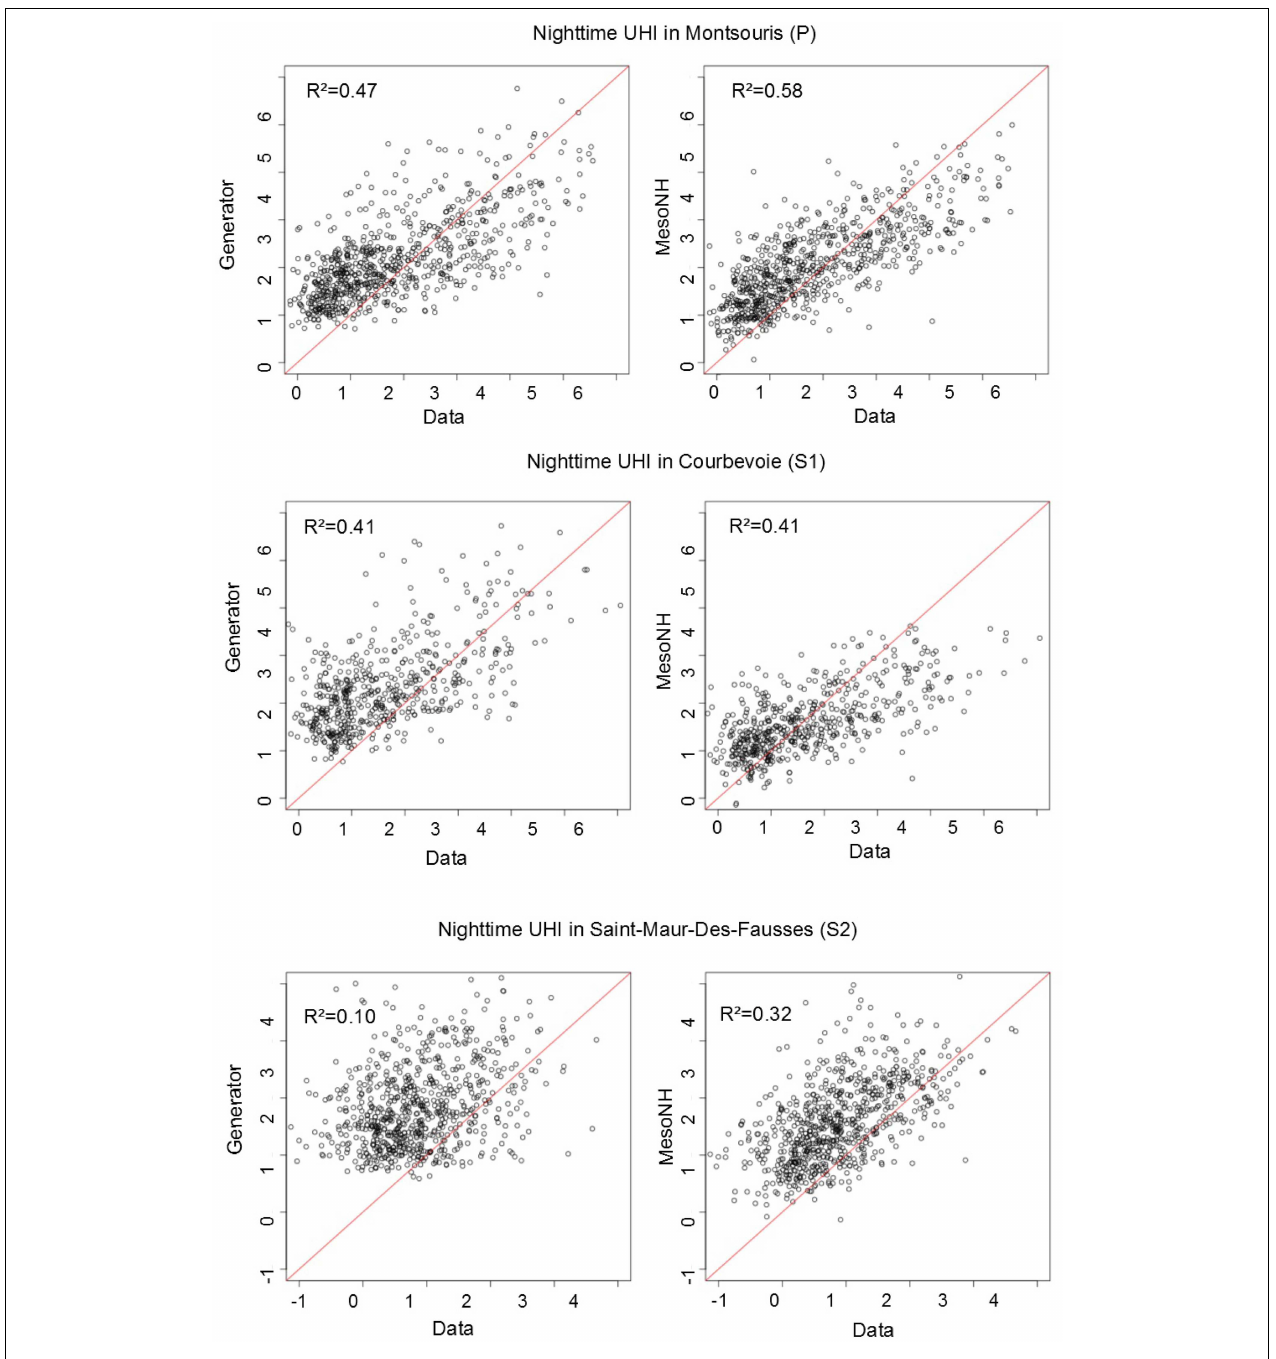
FIGURE 11 | Comparison of the UHI at 2 m in Paris during the night (0:00 and 3:00 A.M. UTC) over a year of the data of three operational weather stations with simulations computed by the